Question: Describe this figure in one sentence.
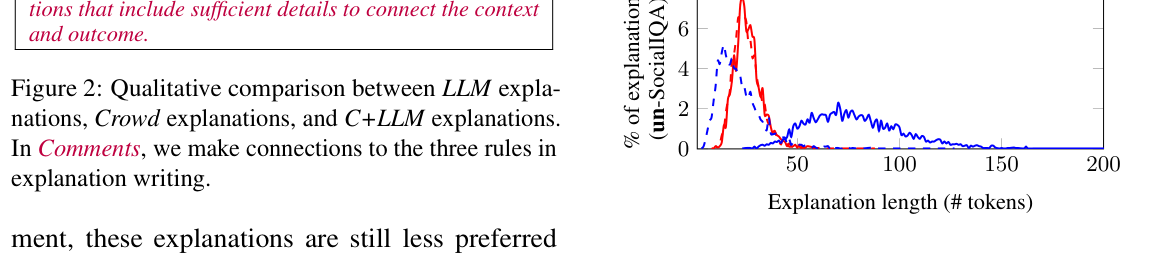
Answer: Distribution of explanation lengths in un- RocStories (top) and un-SocialIQA (bottom), computed on the development sets of each data subset.